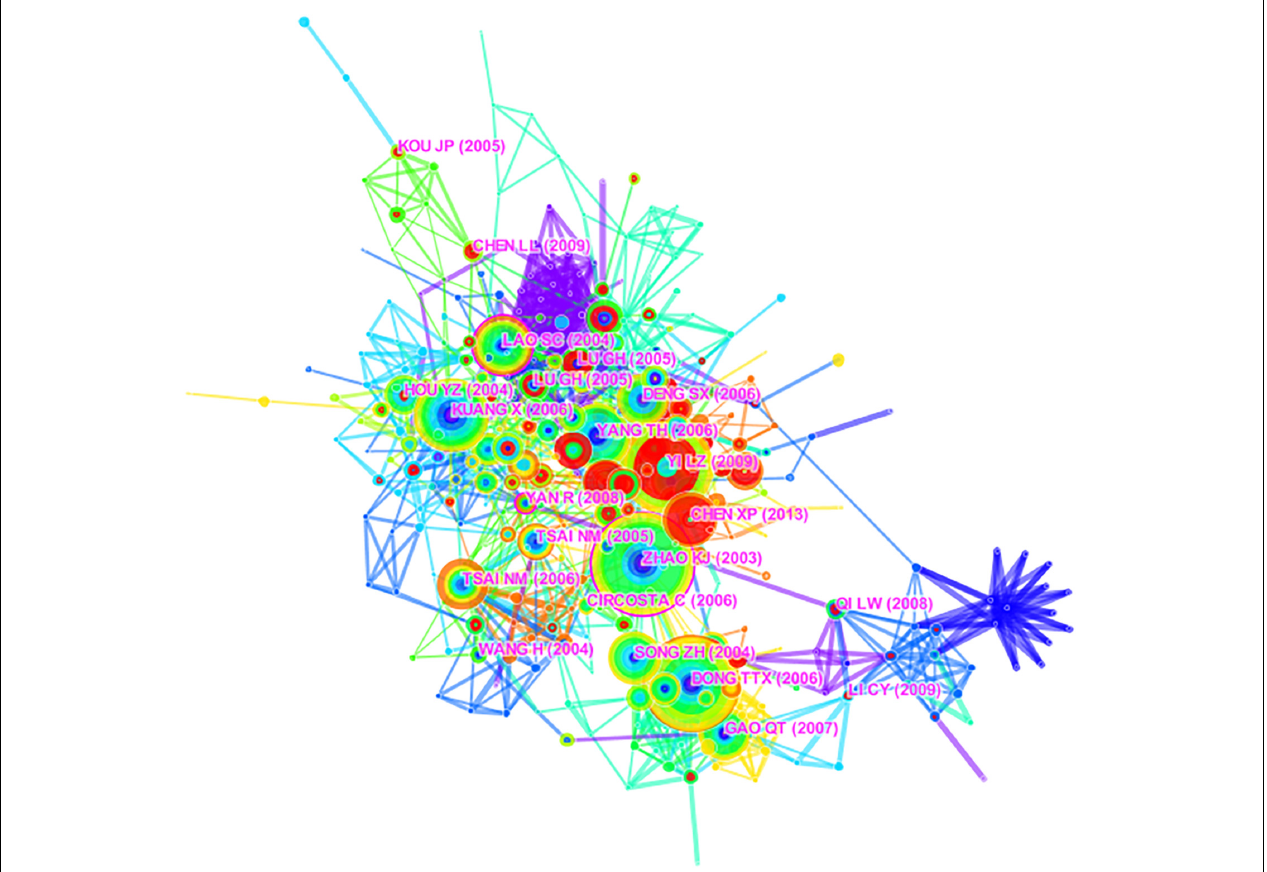
FIGURE 3 | The network map of document co-citation of Angelica sinensis